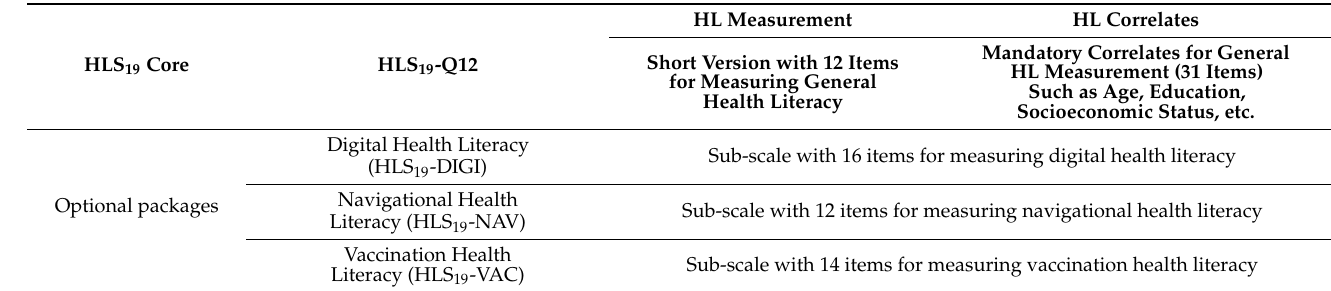
Table 1. Overview of HLS 19 and Optional